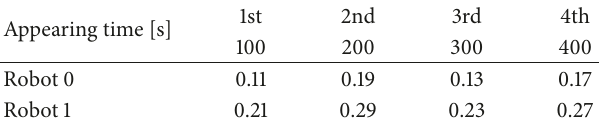
Table 5: Carrying velocity of added objects.